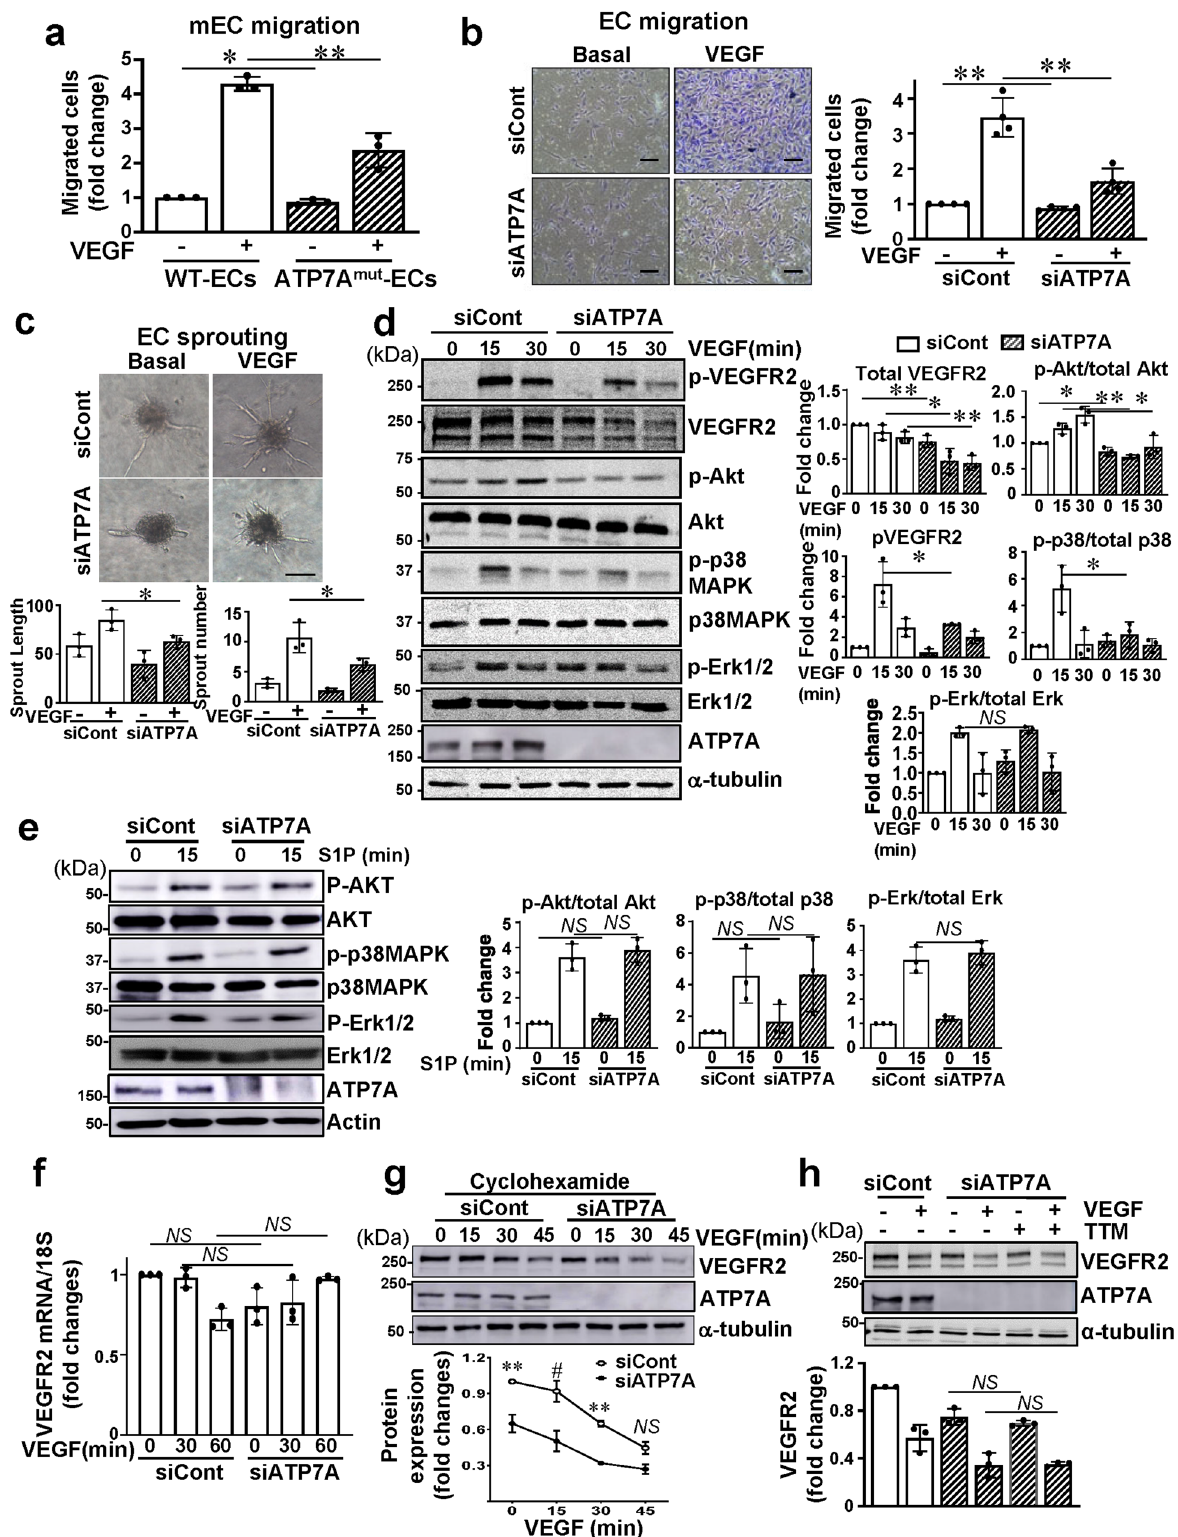
internalization (Fig. 4a). Of note, ATP7A knockdown promoted VEGF-induced reduction of cell surface VEGFR2. Interestingly, Fig. 4b, c using co-localization analysis show that VEGF stimu- lation for 15 min promoted VEGFR2 internalization to Rab5- positive early endosomes, but not Lamp2-positive lysosomes, which was followed by traf fi cking to Rab11-positive